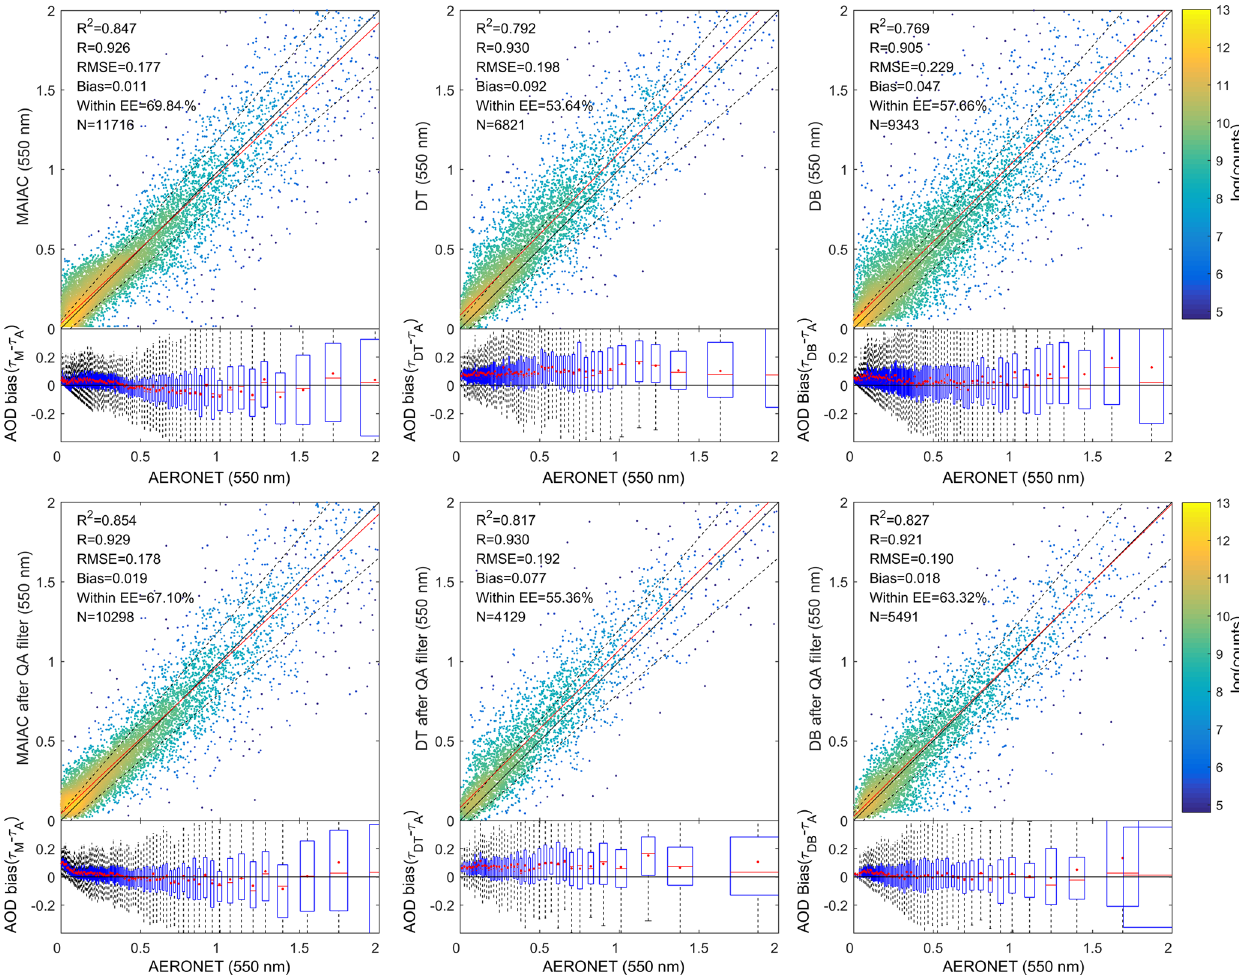
Figure 2. Overall accuracy evaluation of MAIAC, DT, and DB AOD versus AERONET AOD at 550nm before and after the QA filter. The black line, red line, and dashed line in the scatterplot are the 1:1 reference line, regression line, and expected error (EE = ± ( 0 . 05 + 0 . 15 × AOD ) ) line, respectively. The matchup pairs are separated into 100 bins along with AERONET AOD values. The AOD bias box plot uses the 25% and 75% percentiles for each of 100 bins. The red points in the box plot are the mean bias for each of 100